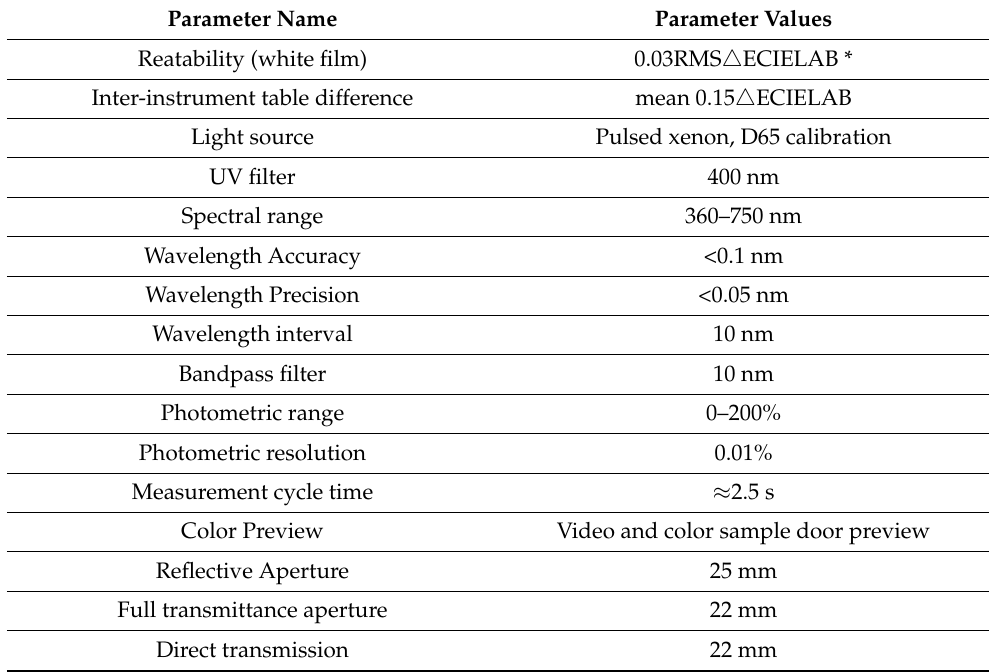
Table 1. Photometric test